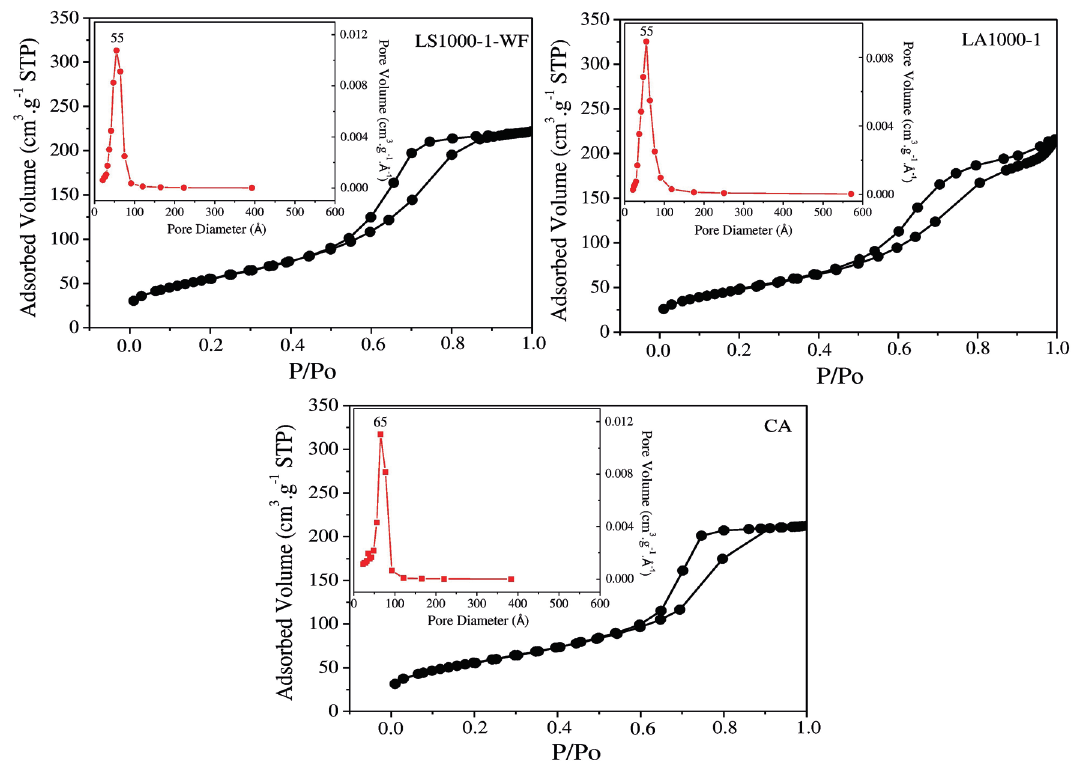
Figure 4: Nitrogen adsorption-desorption isotherms and pore size distribution curves (inserted into the graphics) for the calcined samples at 800 o C. energy milling of aluminum cans, by precipitation